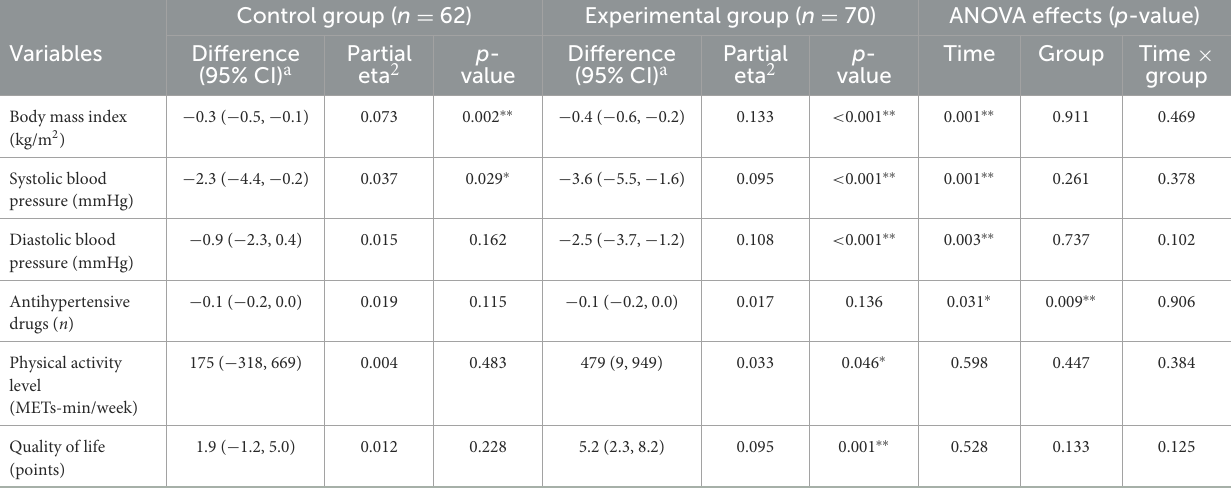
TABLE 2 Intention-to-treat analysis. Intragroup comparisons: baseline vs.